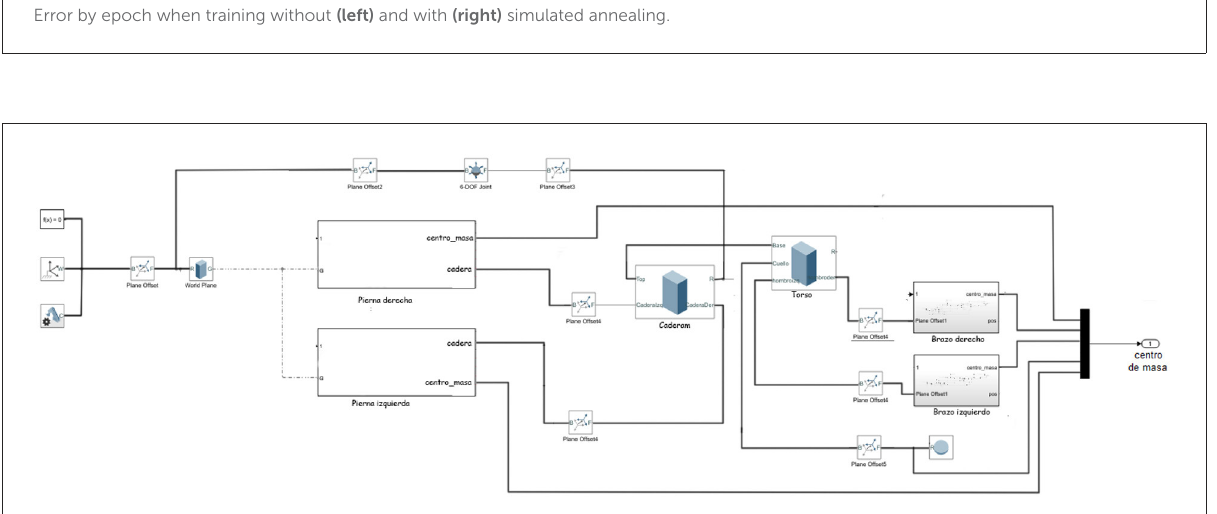
FIGURE2 Block model of the complete